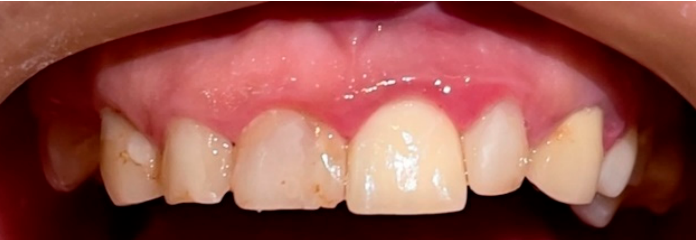
Figure 1. Superior arch localized gingivitis: redness, oedema, and modification of the normal teeth contour.